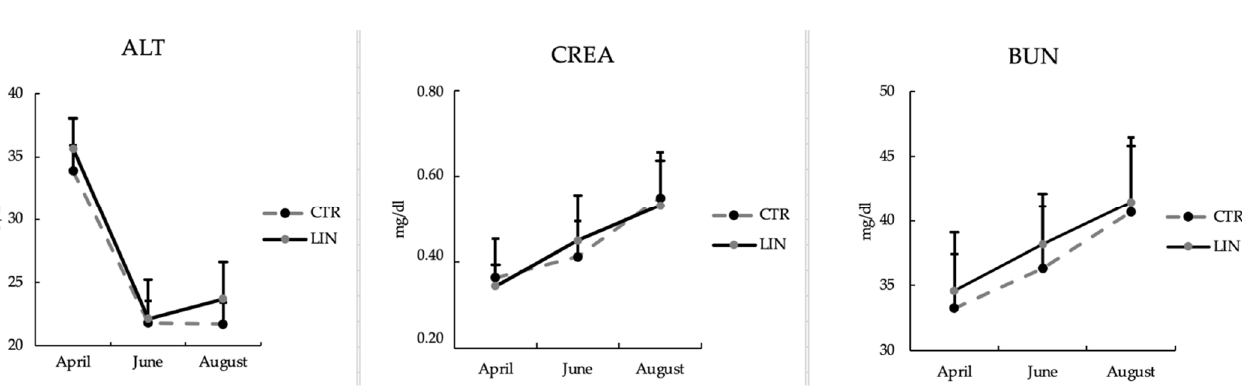
Figure 4. Indicators of liver and kidney status (mean ± SD) of goats during the experimental period of control (CTR) and linseed supplementation (LIN) groups. ALT: alanine amino transferase; CREA: creatinine; BUN: blood urea nitrogen.